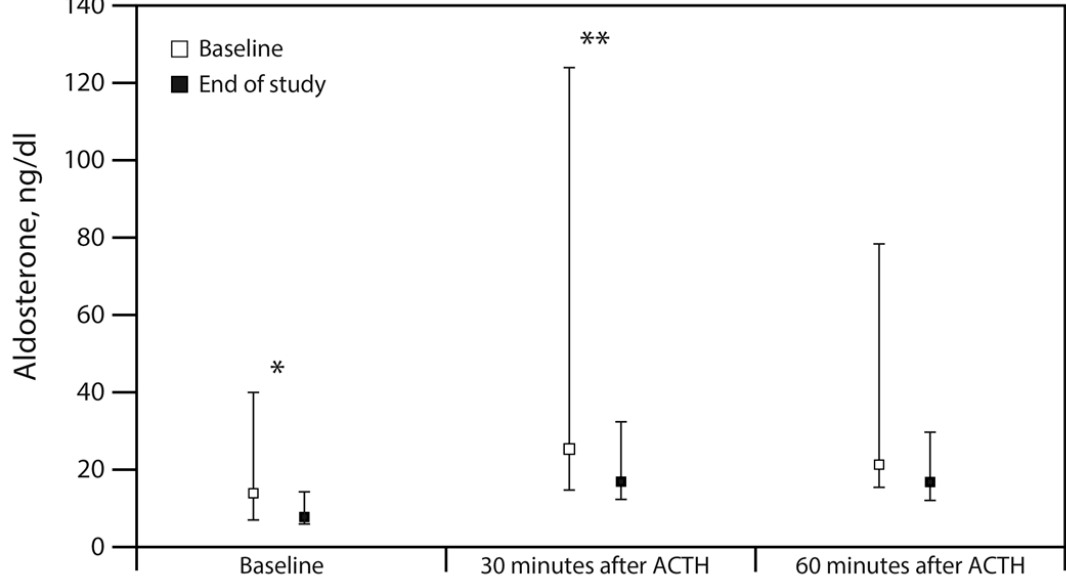
Figure 1. Aldosterone changes during the 250 mcg ACTH stimulation test at the beginning and end of the study. The distribution of aldosterone is shown as median and first and third quartile (Q1–Q3). ACTH indicates adrenocorticotropic hormone; * p < 0.05; ** p < 0.01.